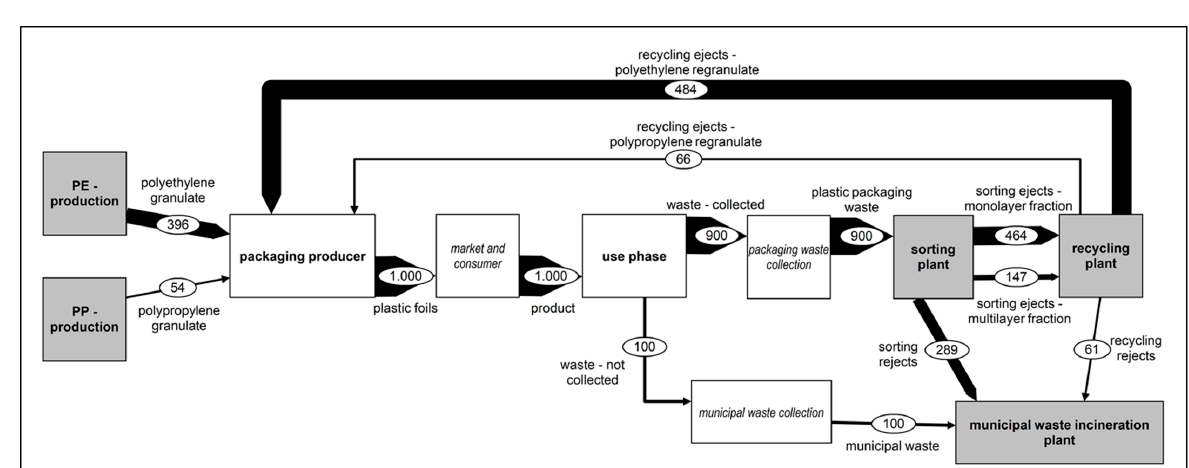
Figure A6. Material flows—Scenario 5—Recycling Goals 2025.